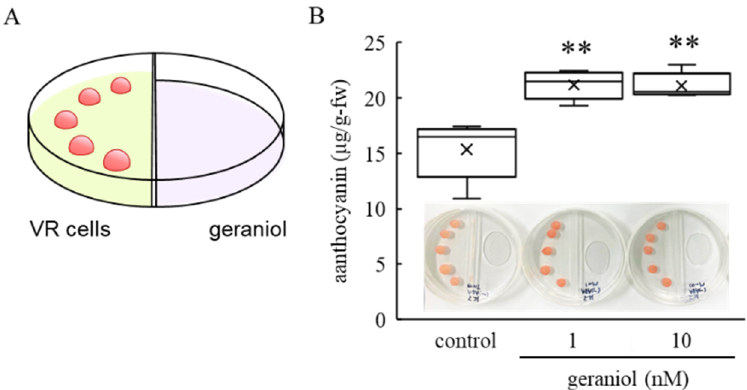
Figure 4. Effect of geraniol on anthocyanin accumulation in grape cultured cells. ( A ) Experimental design for VR cell treatment with geraniol. VR cells were incubated on modified LS agar medium in one section of a split Petri dish having two sections, and 1 or 10 nM geraniol or diluted ethanol as control solution was added into the other section of the same dish. ( B ) Anthocyanin content in VR cells treated with geraniol 10 days after treatment. Crosses ( × ) indicate means of five independent experiments. Representative VR cells are shown in the graph. ** p < 0.01 compared with control. Control, treated with diluted ethanol.